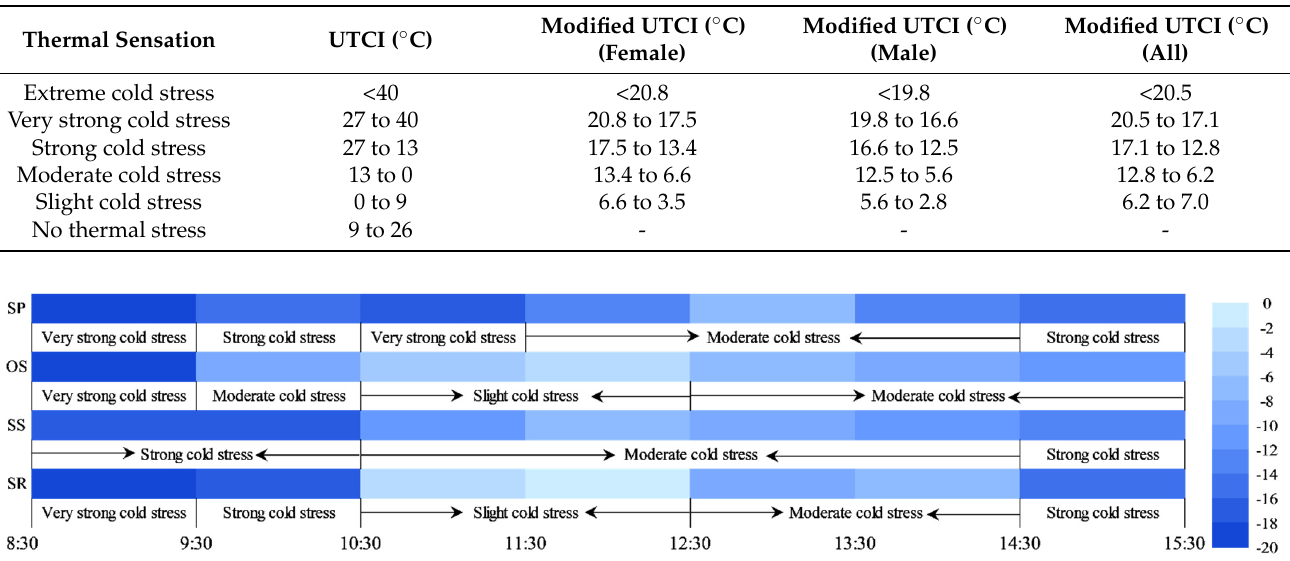
Table 6. UTCI calibrations for different stress categories.